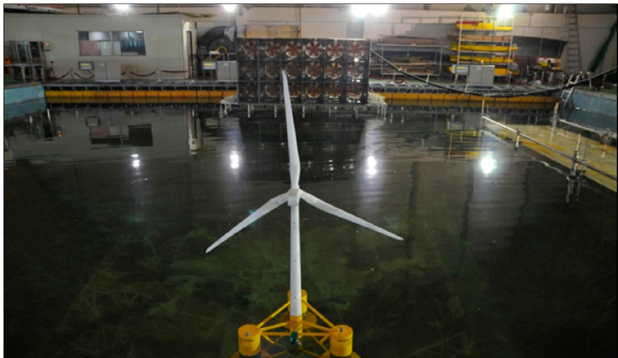
Figure 2. Model tests of the 5 MW semi-submersible platform model in the water tank of Ulsan University (UOU). Table 1. OC4 semi-submersible